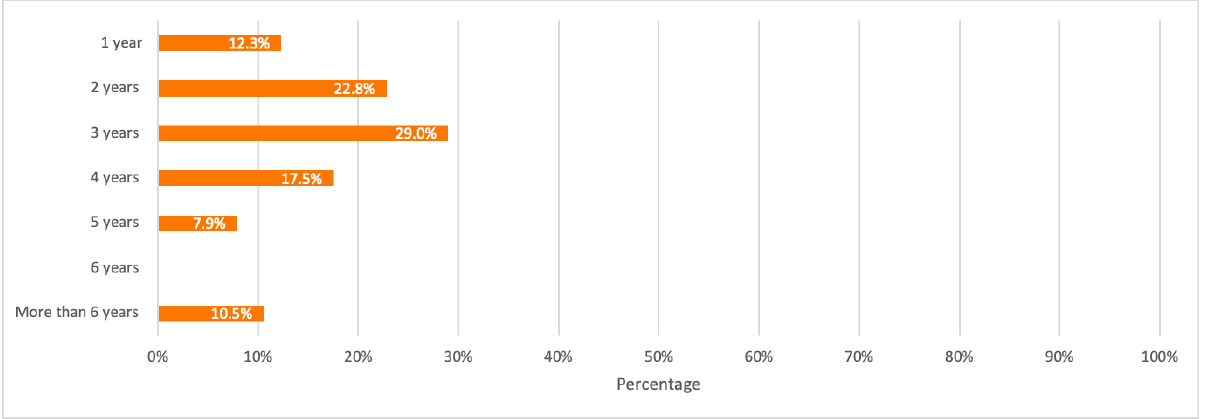
Figure 12. Respondents’ mobile phones active -use duration.